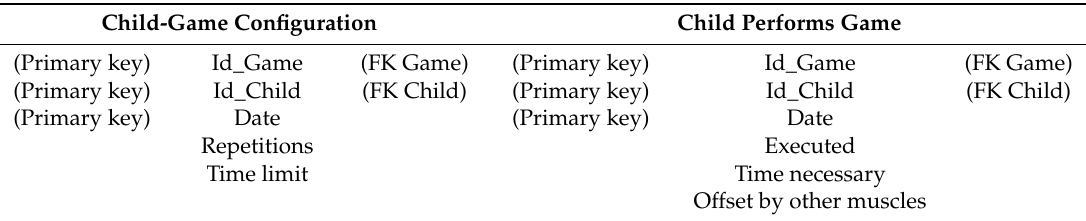
Table 1. Persistence information about games by children.